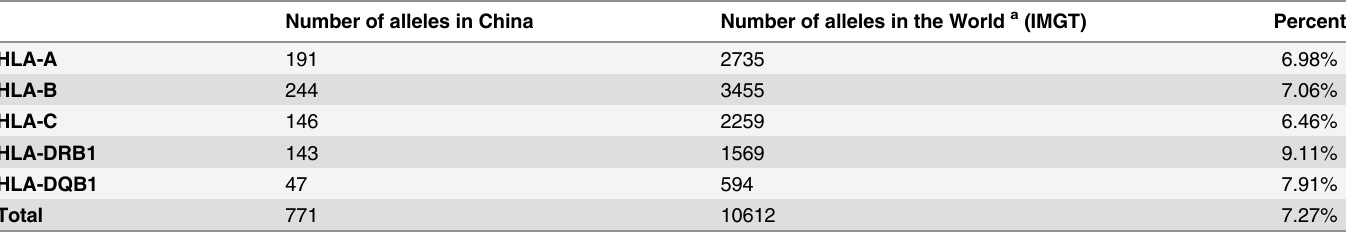
Table 1. Numbers of HLA alleles observed in 169,995 Chinese